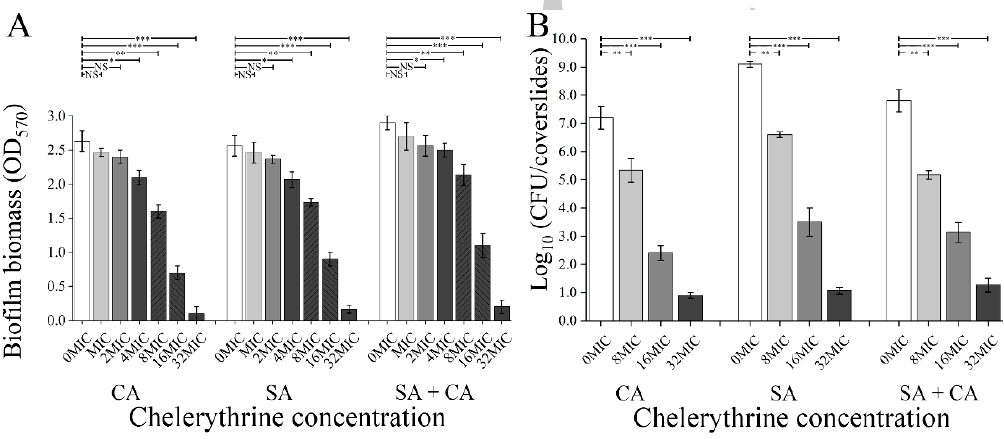
Figure 7. Assessment of eradication effects of different concentrations of chelerythrine on C. albicans (CA) and S. aureus (SA) mono- and dual-species (SA+CA) mature biofilm biomass. (A) The biofilm biomass was assessed using crystal violet staining assay. (B) Mature mono and mixed species biofilms were treated with different concentrations of chelerythrine, and fungal or bacterial cell viability was examined by CFU recovery. Values represent the means of triplicate measurements. Bars represent the standard deviation ( n = 3). * p < 0.05; ** p < 0.01; *** p < 0.001; NS, not significant.